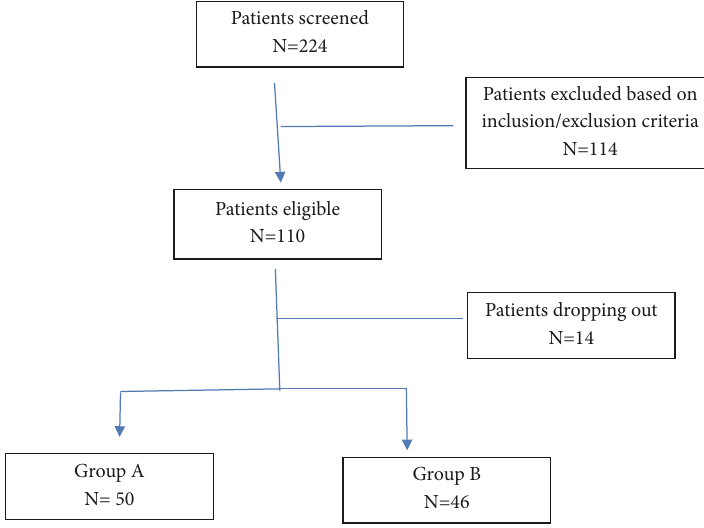
Figure 1: The flowchart of the participating